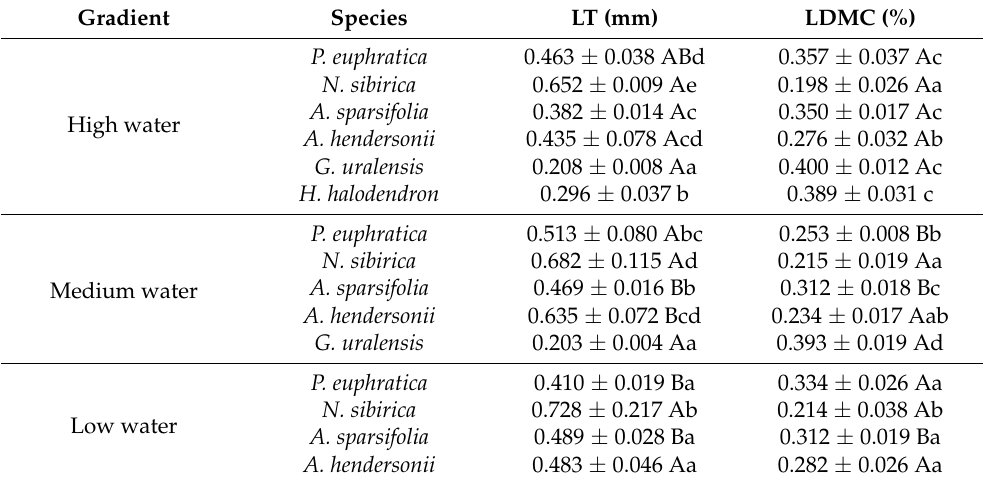
Table 3. Differences in leaf structure characteristics among three water gradients and